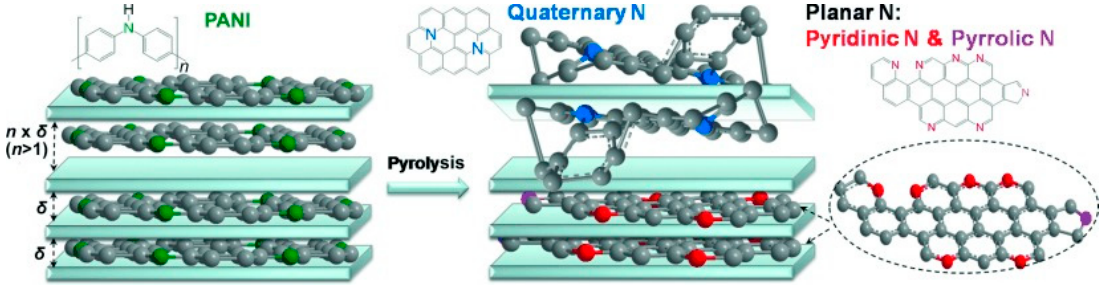
Figure 7. Schematically showing the controlled synthesis of N-doped carbons comprising different nitrogen doping configurations with MMT serving as nanoreactor. Reprinted with permission from Ref. [34], 2013 WILEY-VCH.